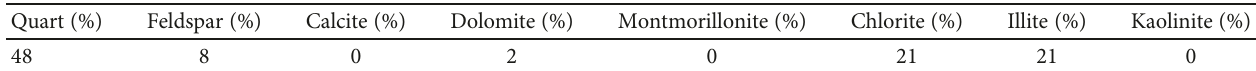
Table 2: Mineral composition of the tested